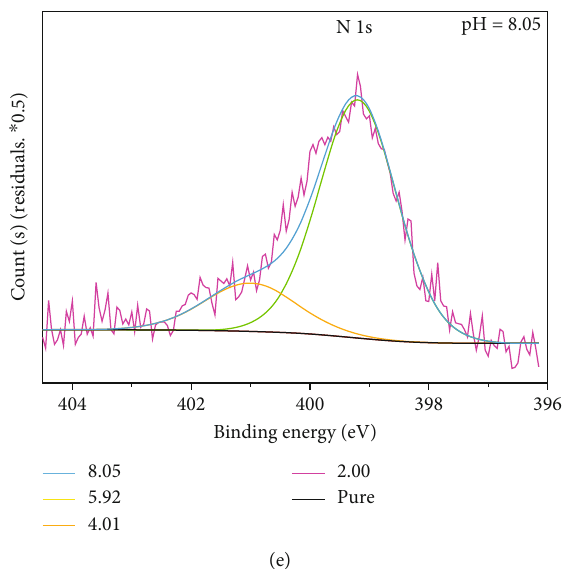
Figure 7: The best fi t of the N 1s XPS spectra of acid δ -MnO and